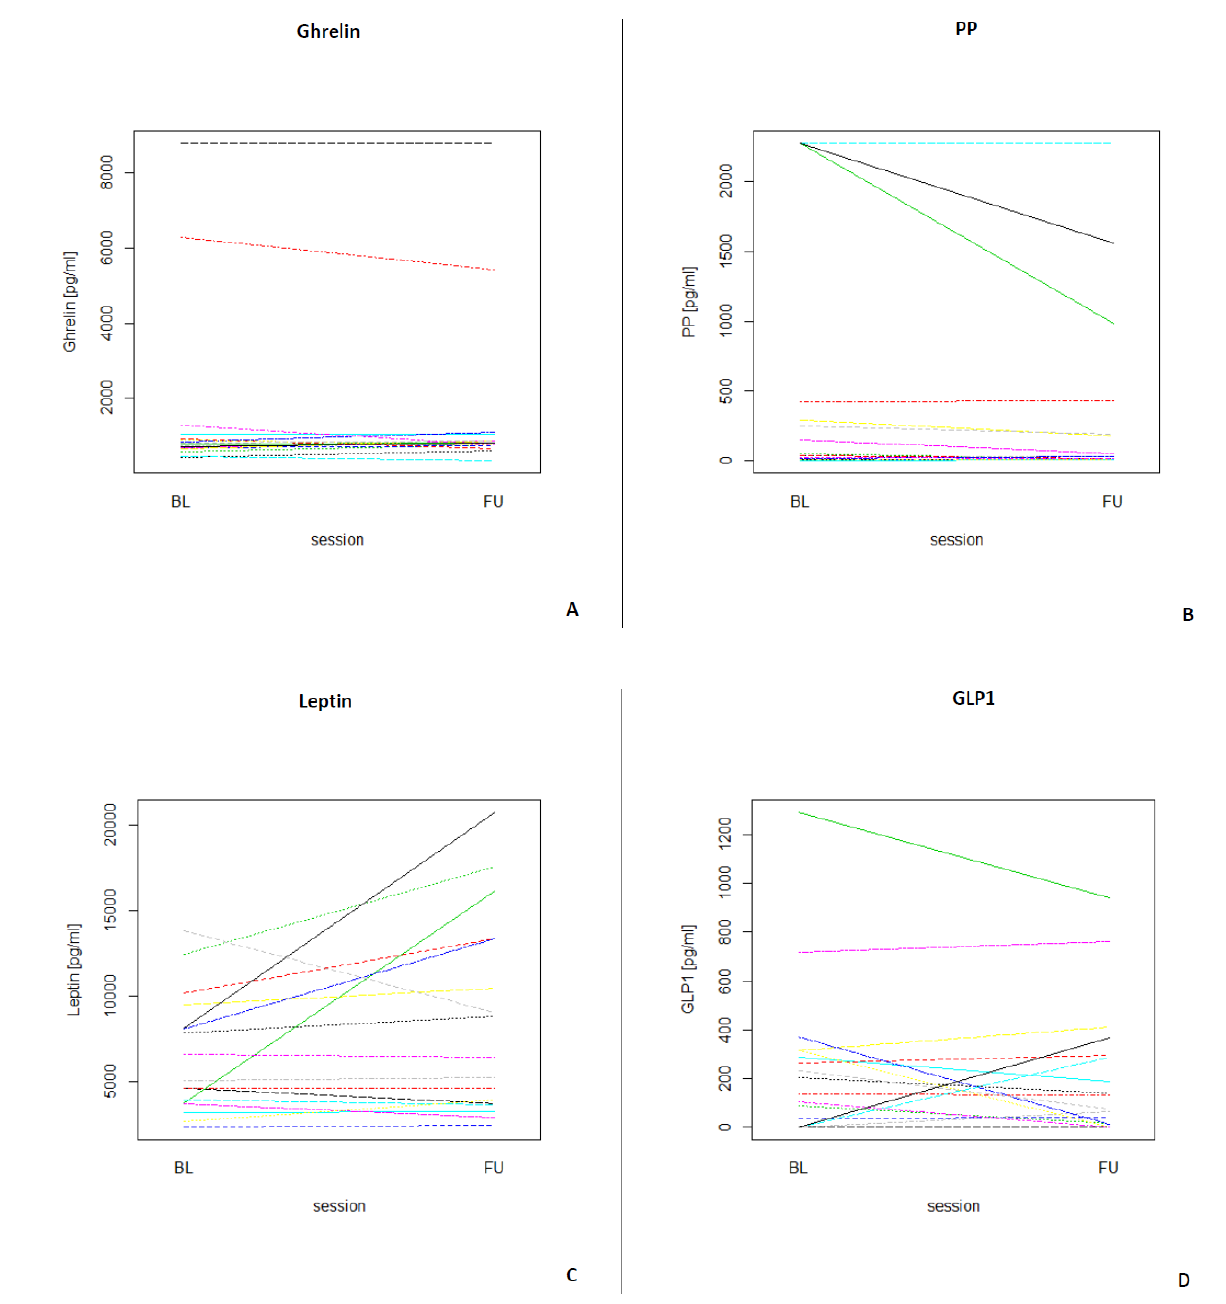
Figure 3. Longitudinal plots of the different GIHs for each participant ( N = 17) for both assessments (BL = baseline, FU = follow-up). ( A ) Individual ghrelin values for all participants. ( B ) Individual PP values for all participants. ( C ) Individual leptin values for all participants. ( D ) Individual GLP1 values for all participants.